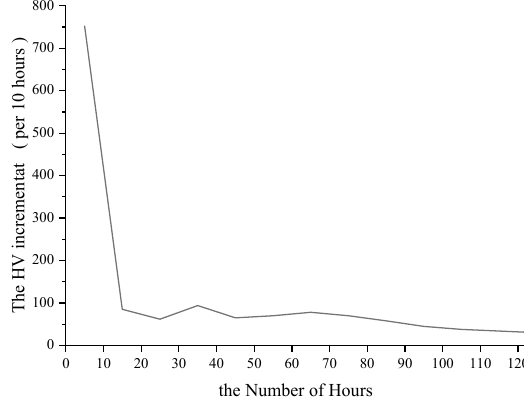
Figure 6. The HV increment of peak hours (per 10 h).